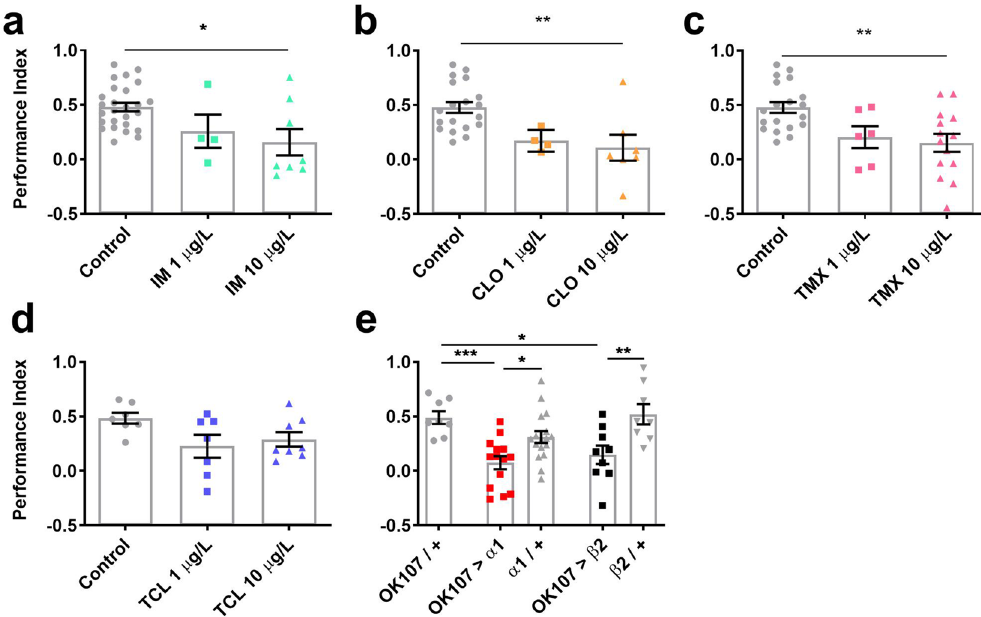
Figure 1. Field relevant concentrations of neonicotinoids or knockdown of Dα1 or Dβ2 in the mushroom bodies reduced 1 h memory. 1 h memory was reduced in flies exposed to field relevant concentrations of 1 or 10 μg/L ( a ) imidacloprid (IM) ( χ 2 2 ) = 7.3, p = 0.026), ( b ) clothianidin (CLO) ( χ 2 2 = 12.4, p = 0.002), ( c ) thiamethoxam (TMX) ( χ 2 2 = 9.6, p = 0.008) and not in ( d ) thiacloprid (TCL) ( χ 2 2 = 5.0, p = 0.084). ( e ) Likewise, 1 h memory was reduced in flies with RNAi mediated knockdown of Dα1 ( OK107-Gal4 > uas-nAChR-Dα1 ) or Dβ2 ( OK107-Gal4 > uas-nAChR-Dβ2 ) throughout the mushroom body ( F 2,20 = 4.6, p = 0.023) and compared to genotype controls. Each data point represents ~ 100 flies, n ≥ 4 per treatment. Graphs show mean ± standard error of the mean (SEM) (post hoc pairwise comparisons: p ≤ 0.05*, p ≤ 0.01**, p ≤ 0.001***, p ≤ 0.0001****). The same tests, error bars and p values were used